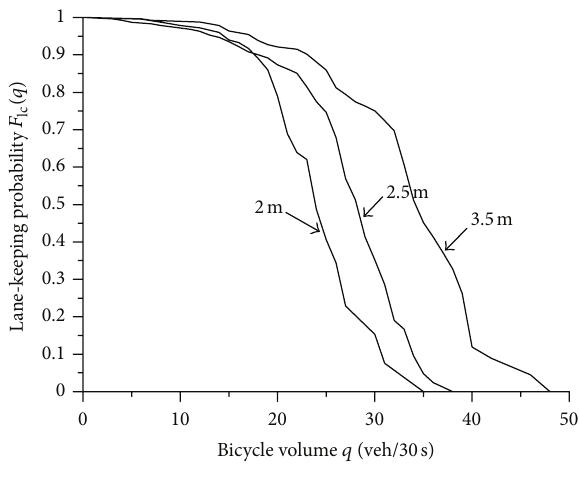
Figure 2: Distributions of the lane-keeping probability with various lane widths.